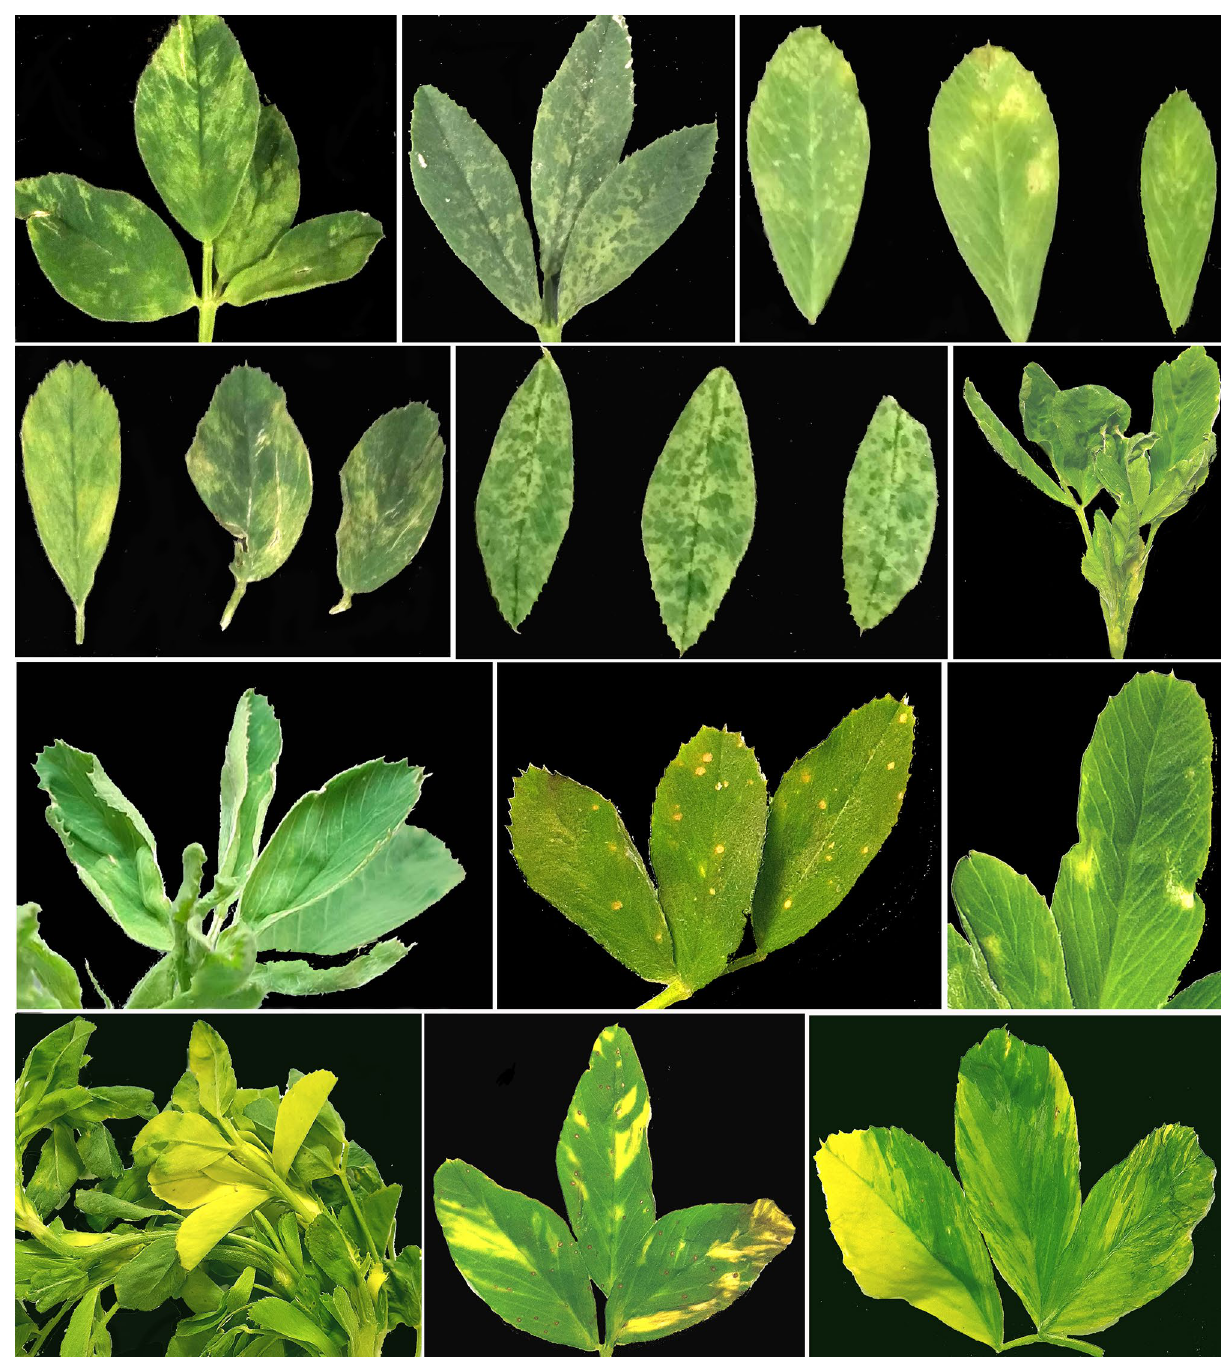
Figure 1. Symptoms observed in alfalfa samples collected from production fields in the U.S. Pacific Northwest in